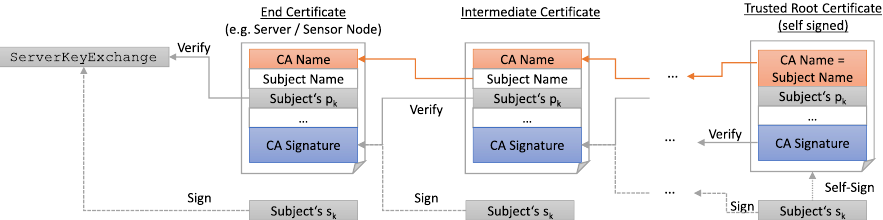
Figure 3. Example for a certificate chain and its application to the TLS